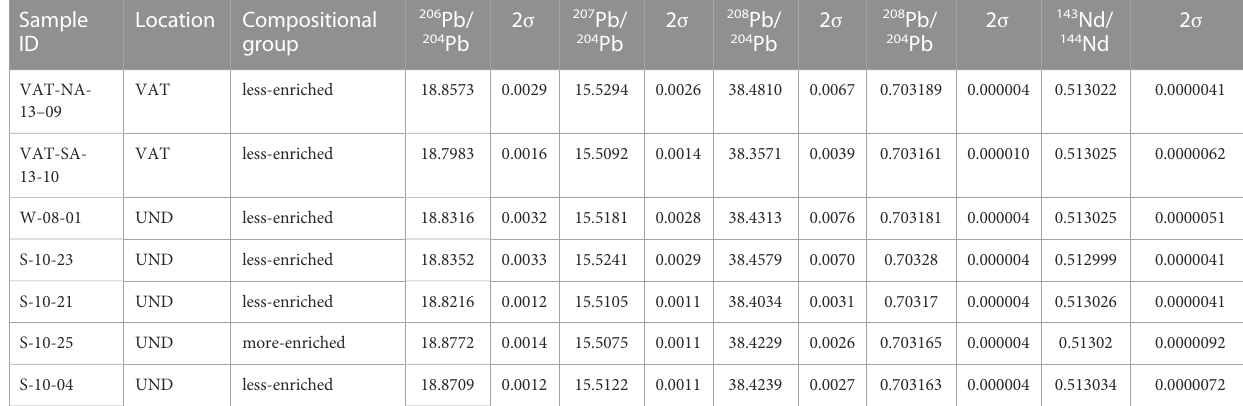
TABLE2Radiogenicisotopedataforwhole-rocksamplesfromUndirhlíðarridge.LocationdescribessamplesiteinUndirhlíðar(UND)orVatnsskarð(VAT)quarries. Compositional group de fi ned by La N /Sm N value as described in the text. Major and trace element data for UND samples are reported in Pollock et al., 2014. All samples are pillow lavas except for S-10-21 (dyke). Details of analytical methods are described in the text. Error is 2 σ standard deviation. Sample